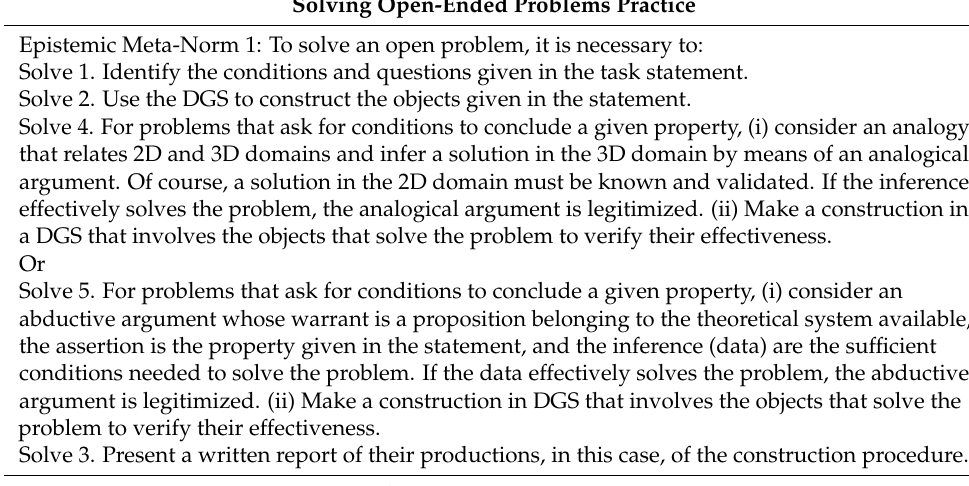
Table 6. Normative procedures of the